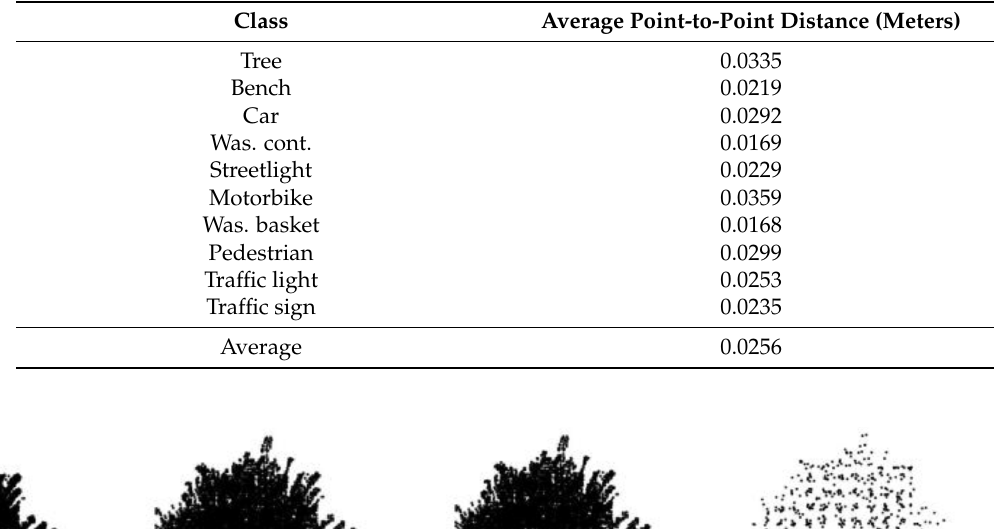
Table 1. Average point density of input data.